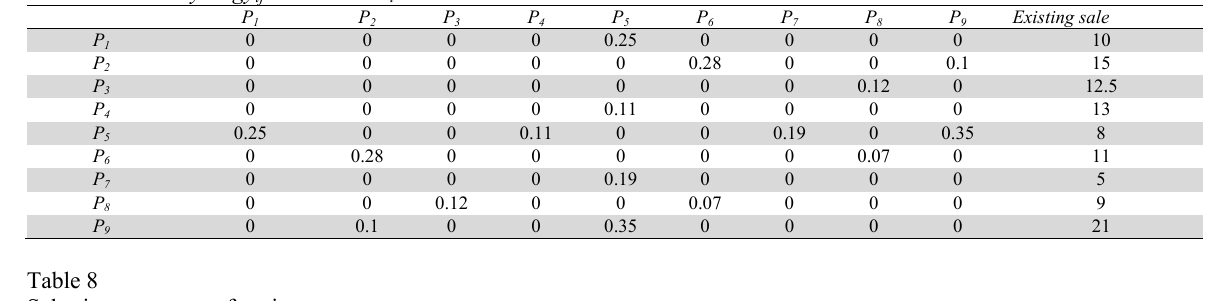
Sales improvement of projects Projects P 1